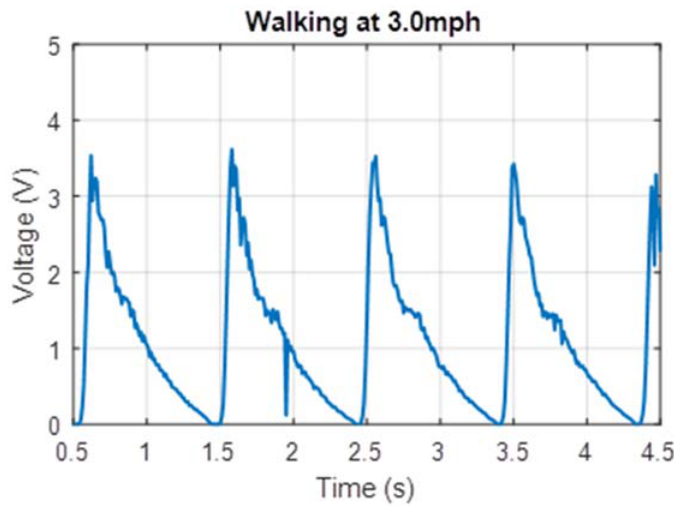
Figure 7. Voltage output measured for 1.0 Hz footsteps.